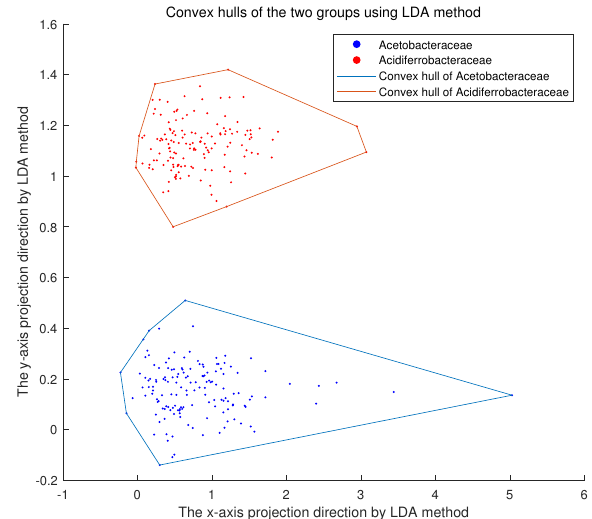
Figure 1. Convex hulls of bacterial family Acetobacteraceae and bacterial family Acidiferrobacter- aceae after dimension reduction by LDA(Linear Discriminant Analysis)